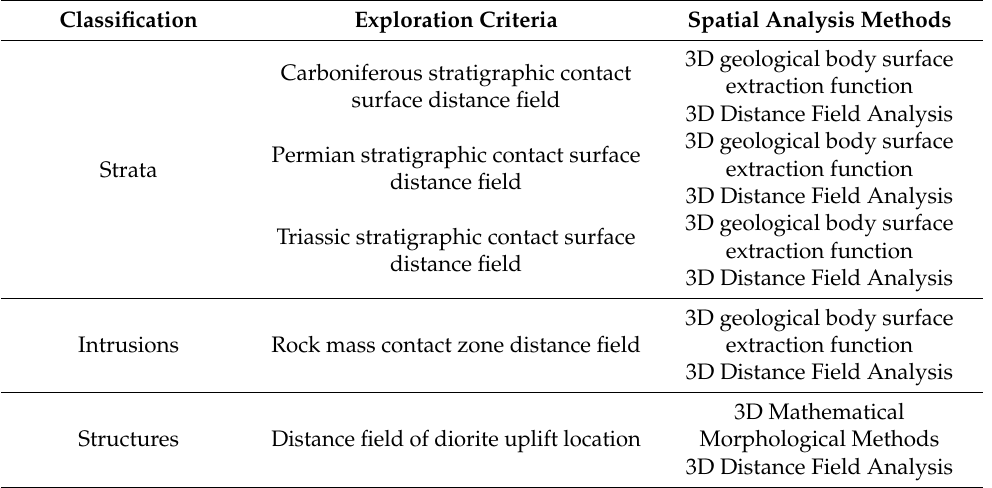
Table 1. 3DMPM model and analysis and extraction method of ore control and indicator elements. (Modified from Ye [43]).